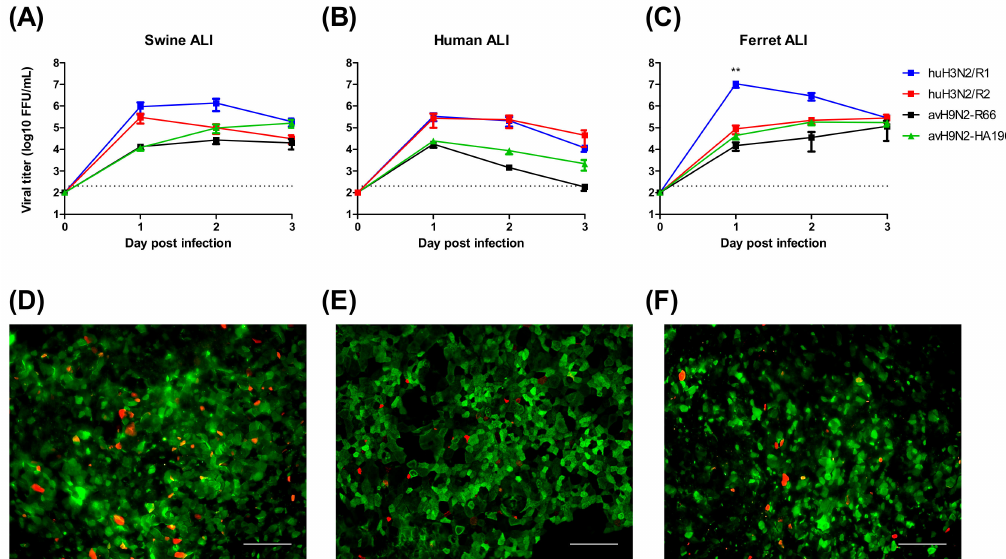
Figure 3. Sialic acid dependence infectivity of IAVs on well-di ff erentiated ALI cultures. Well-di ff erentiated ALI culture from primary swine trachea epithelial cell ( A , D ), human airway epithelium basal cell BCi-Ns1.1 obtained by total airway epithelium brushing ( B , E ) and primary ferret trachea epithelial cells ( C , F ) were infected by avH9N2-R66 and its mutants HA190 or recombinant human H3N2 R1 and R2 viruses ( A – C ). Lectin staining for detecting sialic acid expression on the apical surface of well di ff erentiated ALI cultures showed in the lower panel ( D – F ). Antibodies against SNA (green) and MAA II (red) were used to recognize α 2,6- and α 2,3-linked sialic acids, respectively. The results were shown as means ± SEM. Scale bars, 100 µ m. ** p < 0.01 in one-way ANOVA with Tukey’s post-hoc